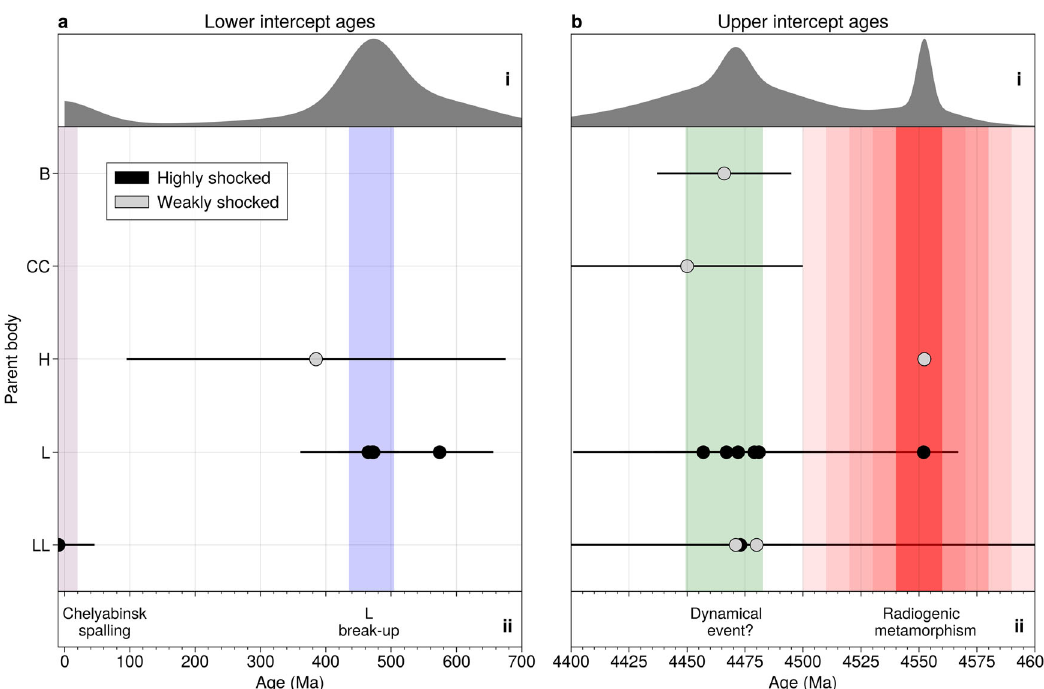
Fig. 6 Compiled shock and phosphate U – Pb age data for meteorites. In ( a ) recent Solar System history and b early Solar System history. a , b – i Stacked Gaussian probability distributions of meteorite phosphate U – Pb ages. a , b -ii Compilation of meteorites and their U – Pb phosphate ages. We divide meteorites by shock stage (see Electronic Appendix) into weakly shocked (S1-3) and highly shocked (S4-6), with the latter being suf fi cient for full phosphate U – Pb resetting 39 . Estimated limits for temporal range of parent body thermal metamorphism are shaded in red. Lower intercept evidence for an L-type break-up event is found at around 470 Ma, as well as a comparatively recent LL-type break-up event involving Chelyabinsk. A cluster of upper- intercept ages is clearly de fi ned at 4480 – 4440 Ma, which may record a major dynamical event in the Solar System. Data from refs. 9,17,26,42,43,45,46,57 – 59 . Error bars are 2 σ